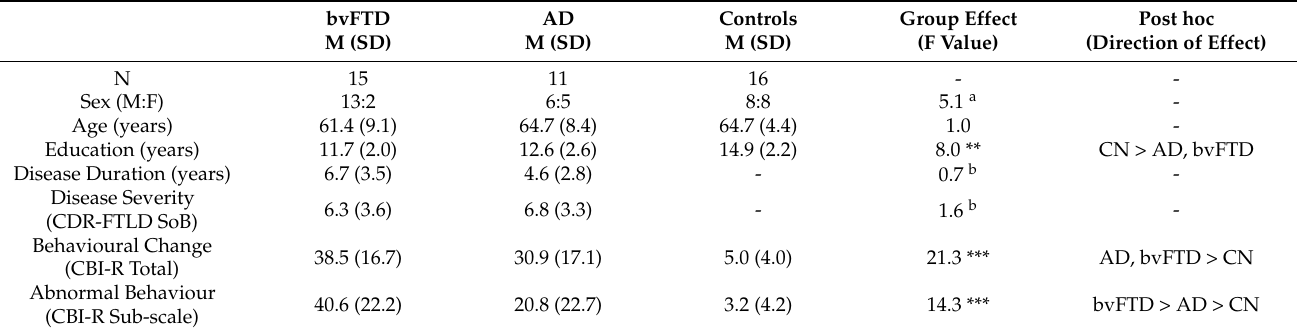
Table 1. Demographics and clinical characteristics of study